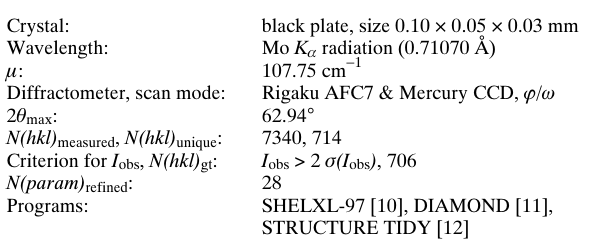
Table 1. Data collection and handling.